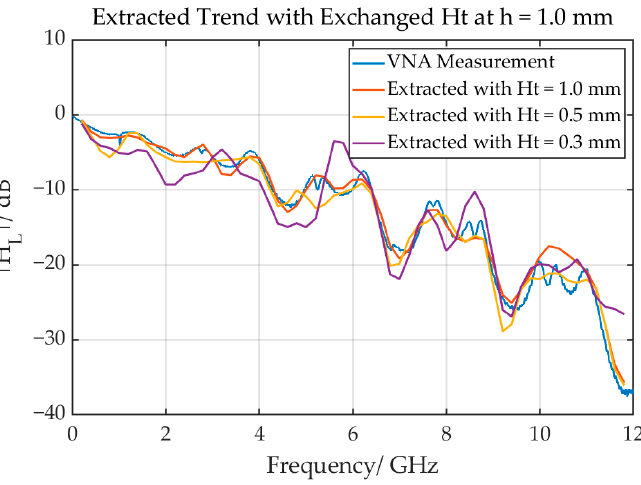
Figure 17. The transmission characteristic extraction at 1 mm distance with exchanged H T ( f ) .